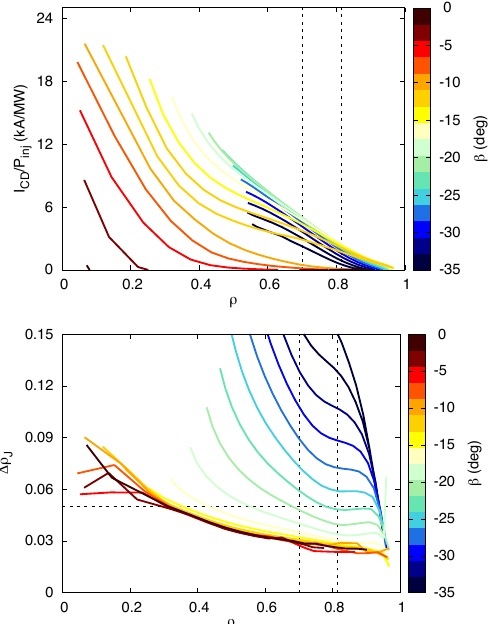
Fig. 3 . (top) Calculated driven current per unit power and (bottom) average current density profile width as functions of the driven current average location. Colours refer to different b values. Every point of every line corresponds to a